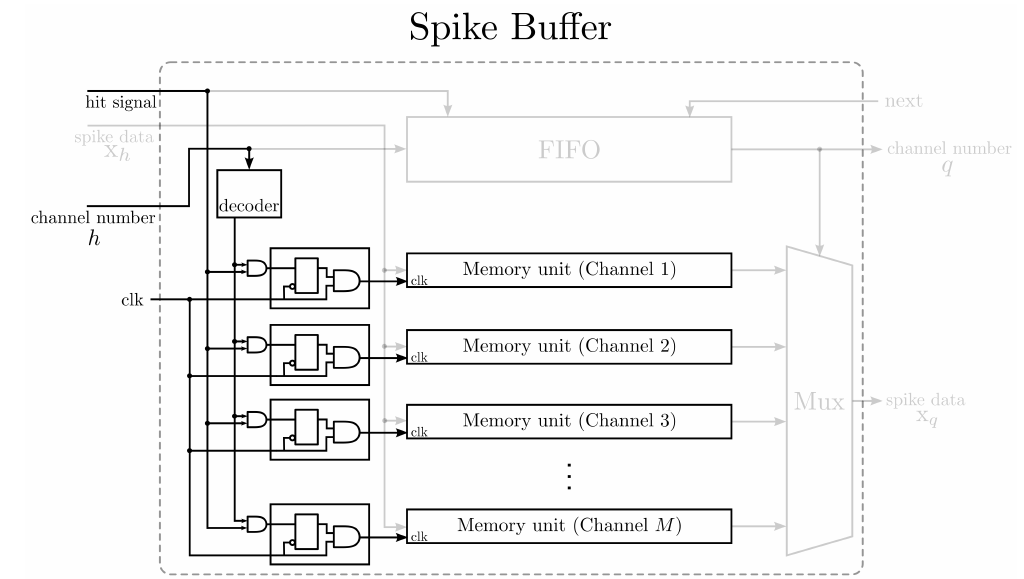
Figure 5. The clock gating circuit for lowering the dynamic power consumption of the spike buffer for